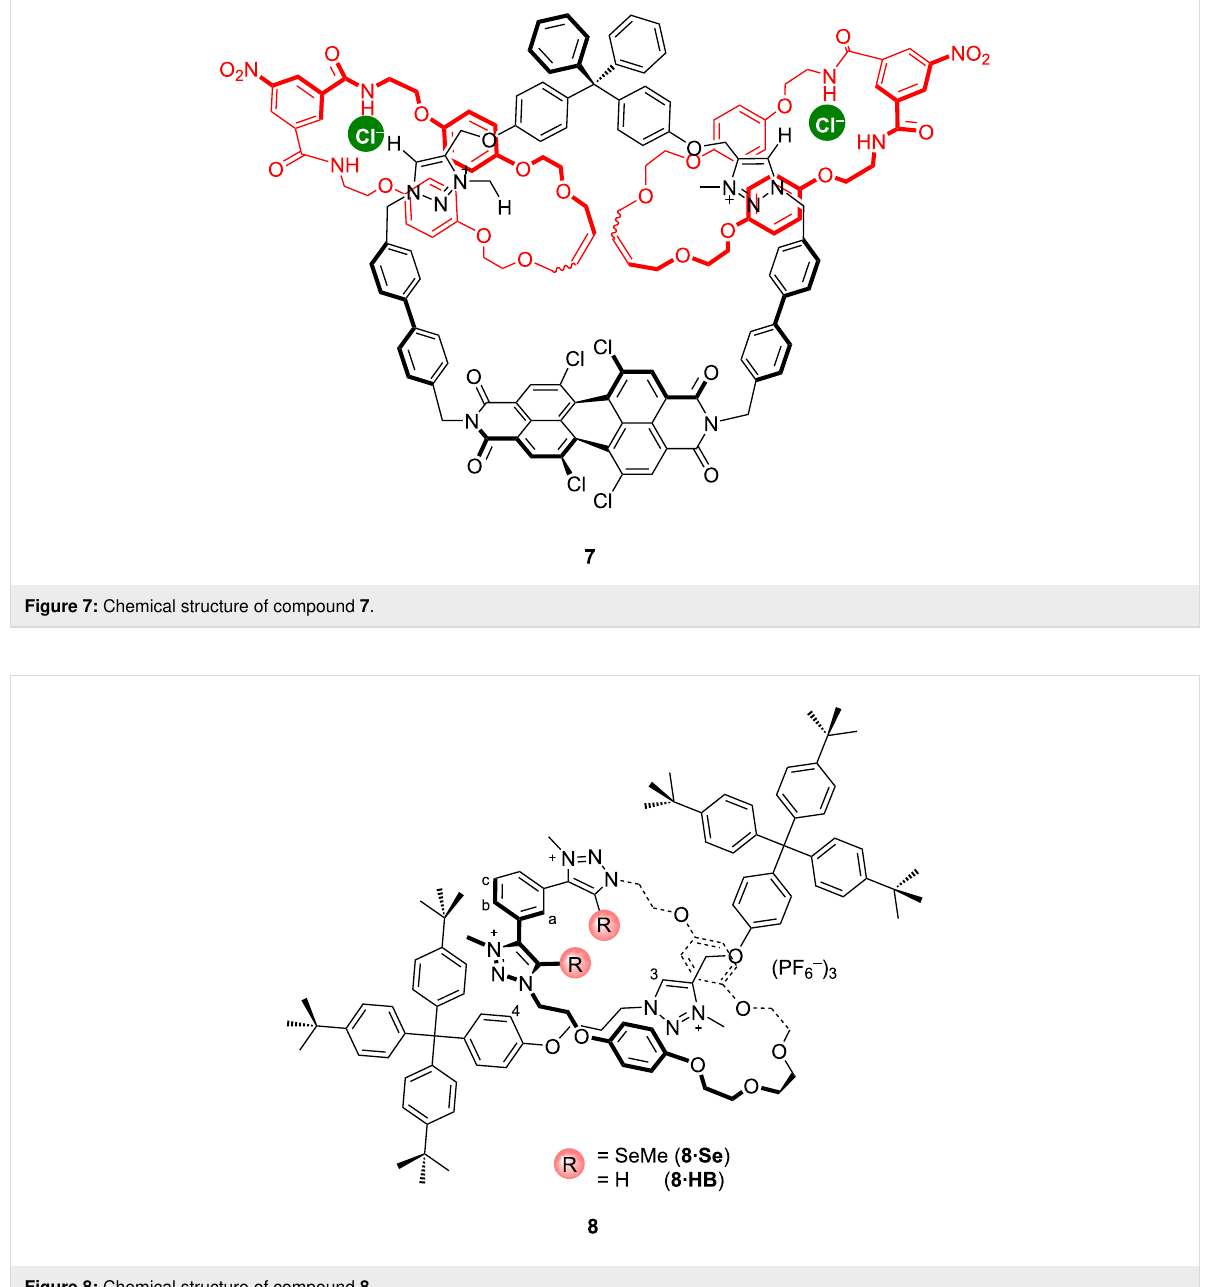
Figure 8: Chemical structure of compound 8